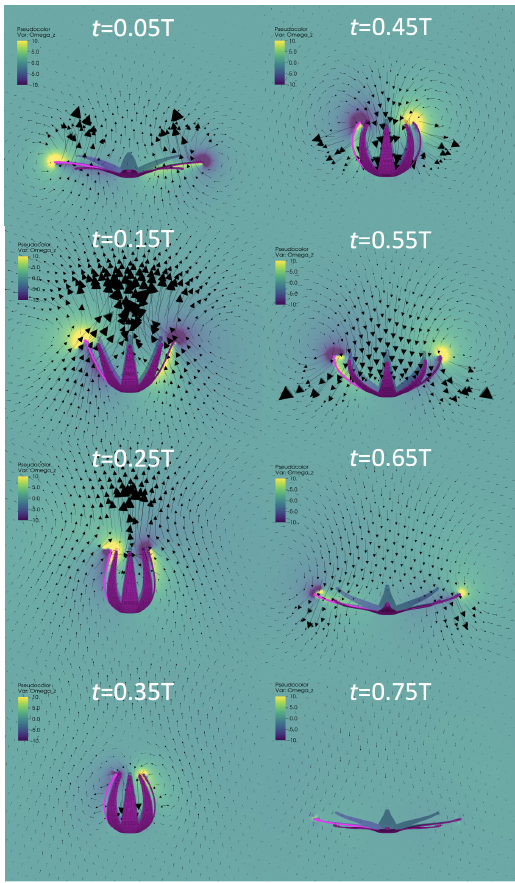
Fig. 5: The z -component of vorticity and the velocity vector field taken on a 2D plane through the central axis of the coral at Re f = 0 . 5 . This Re f corresponds to a smaller scale than would be observed in nature. The colormap shows the value of ω z , the arrows point in the direction of flow, and the length of the vectors correspond to the magnitude of the flow. Shapshots are taken during the fourth pulse at times that are 5%, 15%, 25%, 35%, 45%, 55%, 65%, and 75% through the cycle.